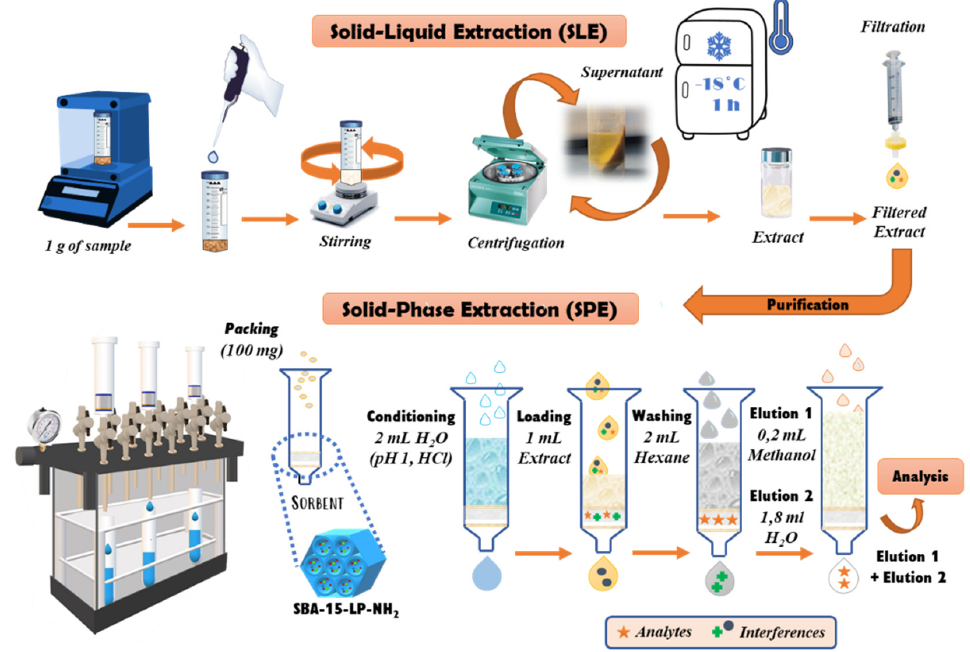
Figure 1. Schematic diagram of sample preparation: solid-liquid extraction (SLE) step and solid-phase extraction (SPE) step.